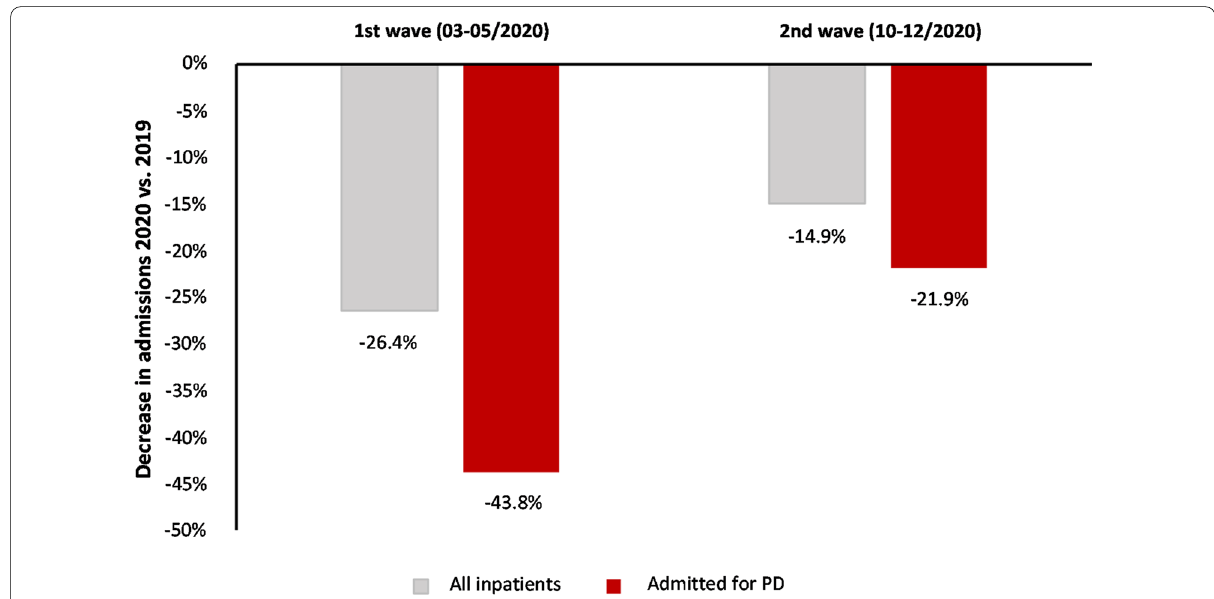
Fig. 2 Decrease in admissions 2020 vs. 2019 for any and Parkinson’s